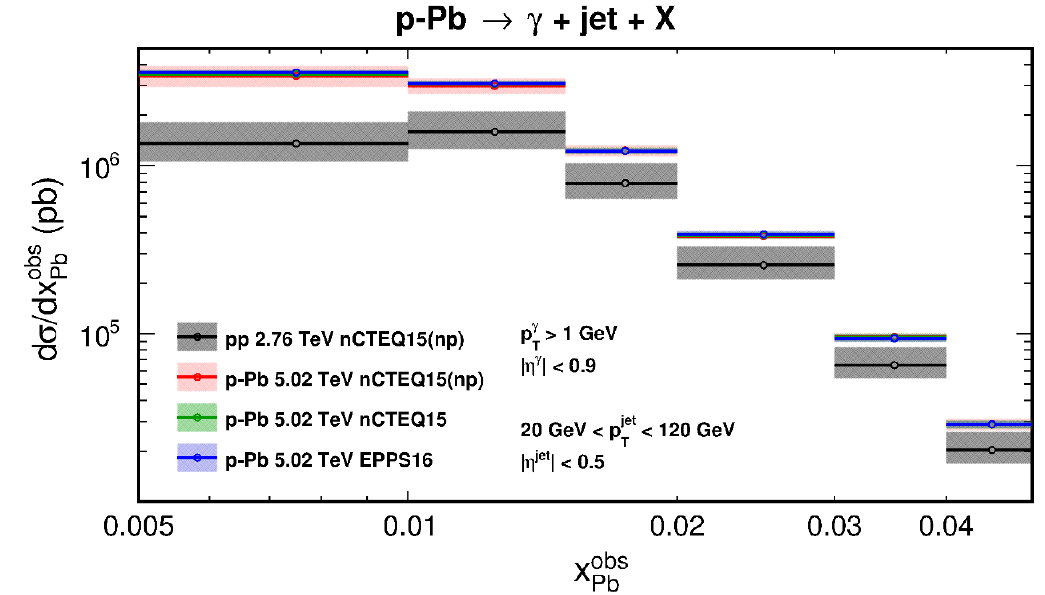
Figure 11 . Nuclear PDF sensitivity of central low- p (cid:13) pPb collisions at the LHC with a nucleon-nucleon centre-of-mass energy of Predictions with nCTEQ15(np) PDFs (red) are compared to those with nCTEQ15 including pion data from RHIC (green) and EPSS16 including weak boson and jet data from LHC (blue). The nCTEQ15 pp baseline is also shown